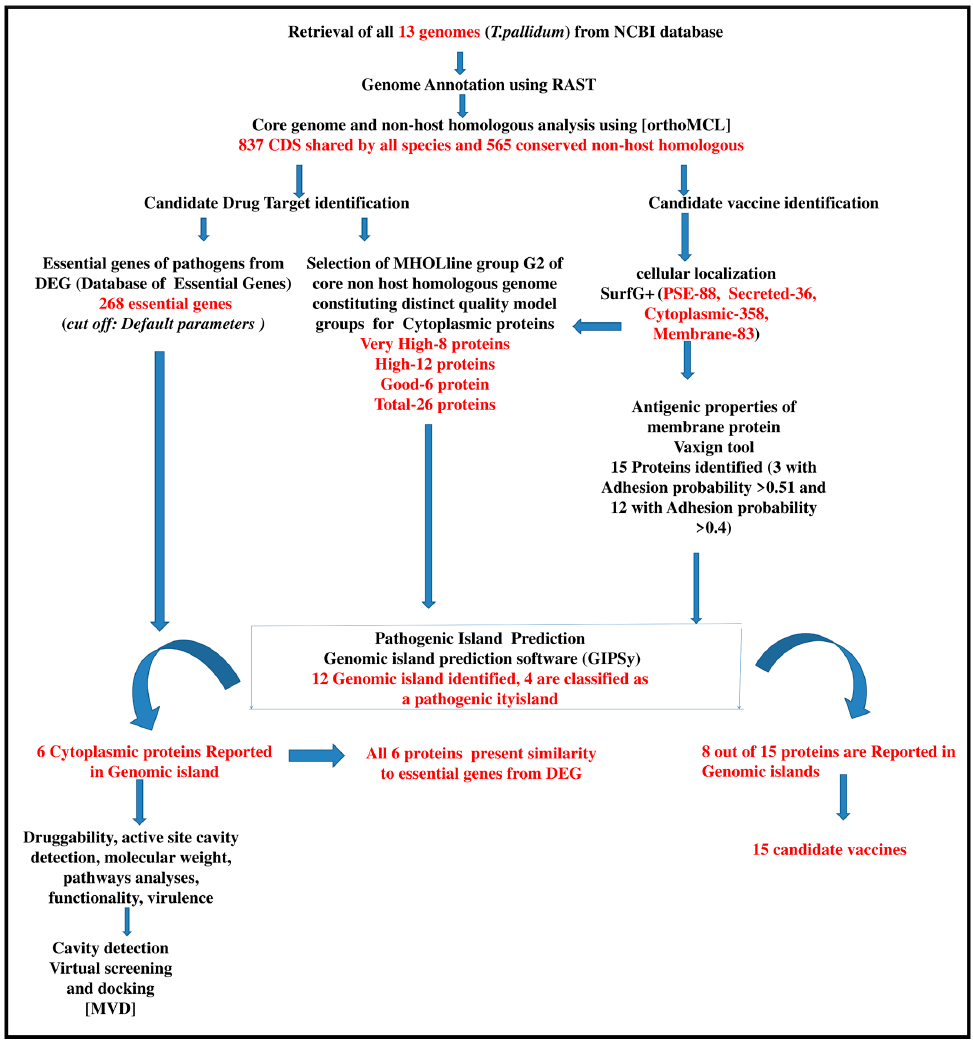
Figure 1. Complete workflow with the number of genes selected in each step and methodologies used. The sentences in black describe the analyses made and the software used in each step. The sentences in red represent the number of proteins selected in each step. CDS = coding DNA sequence; MVD = Molegro Virtual Docker.